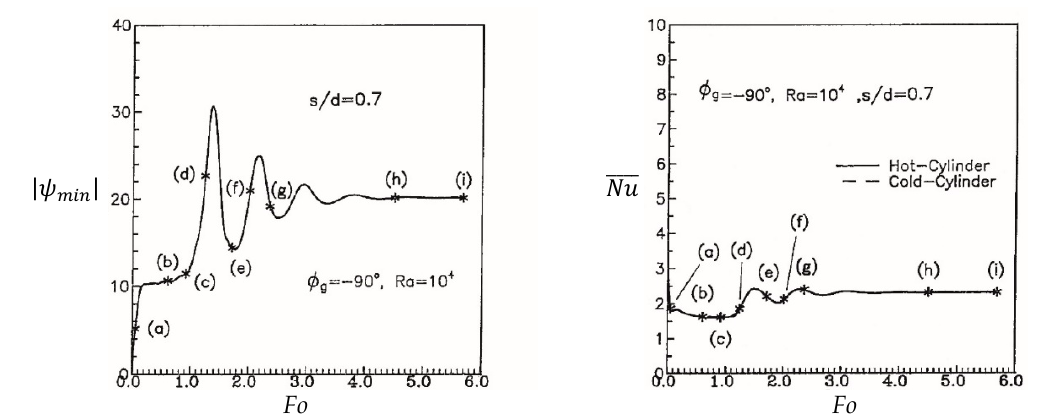
Figure 3. Variation in the minimum stream function value ( left ) and average Nusselt number between two cylinders ( right ) versus time ( φ g = − 90 ◦ , Ra = 10 4 and s / d = 0.7).